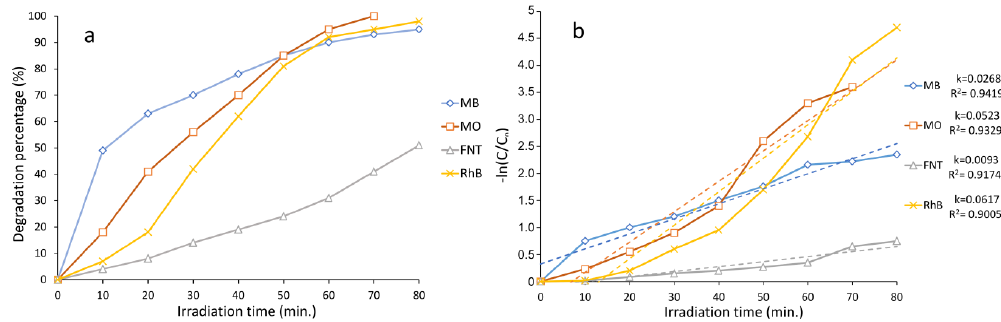
Figure 7. ( a ) Photocatalytic degradation of MB, MO, FNT, and RhB by the S 4 sample under UV light irradiation. ( b ) Pseudo-first-order kinetics of MB, MO, FNT, and RhB degradation by the S 4 sample.